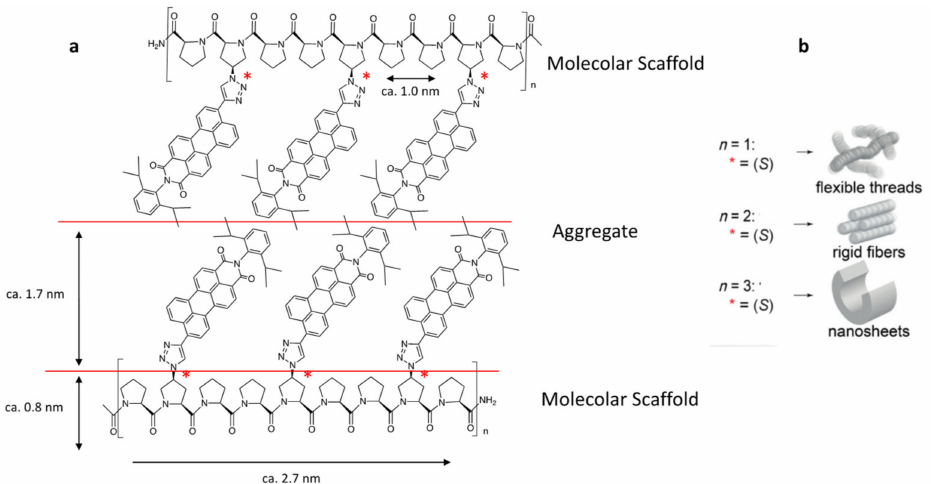
Figure 3. ( a ) General structure of oligoproline-perylene monoimide aggregate and the estimated molecular dimensions. It is interesting that a new stereocenter is introduced when a chiral perylene monoimide is bound with polyproline II (molecular scaffold) ( b ) models of supramolecular assemblies based on different units (adapted from